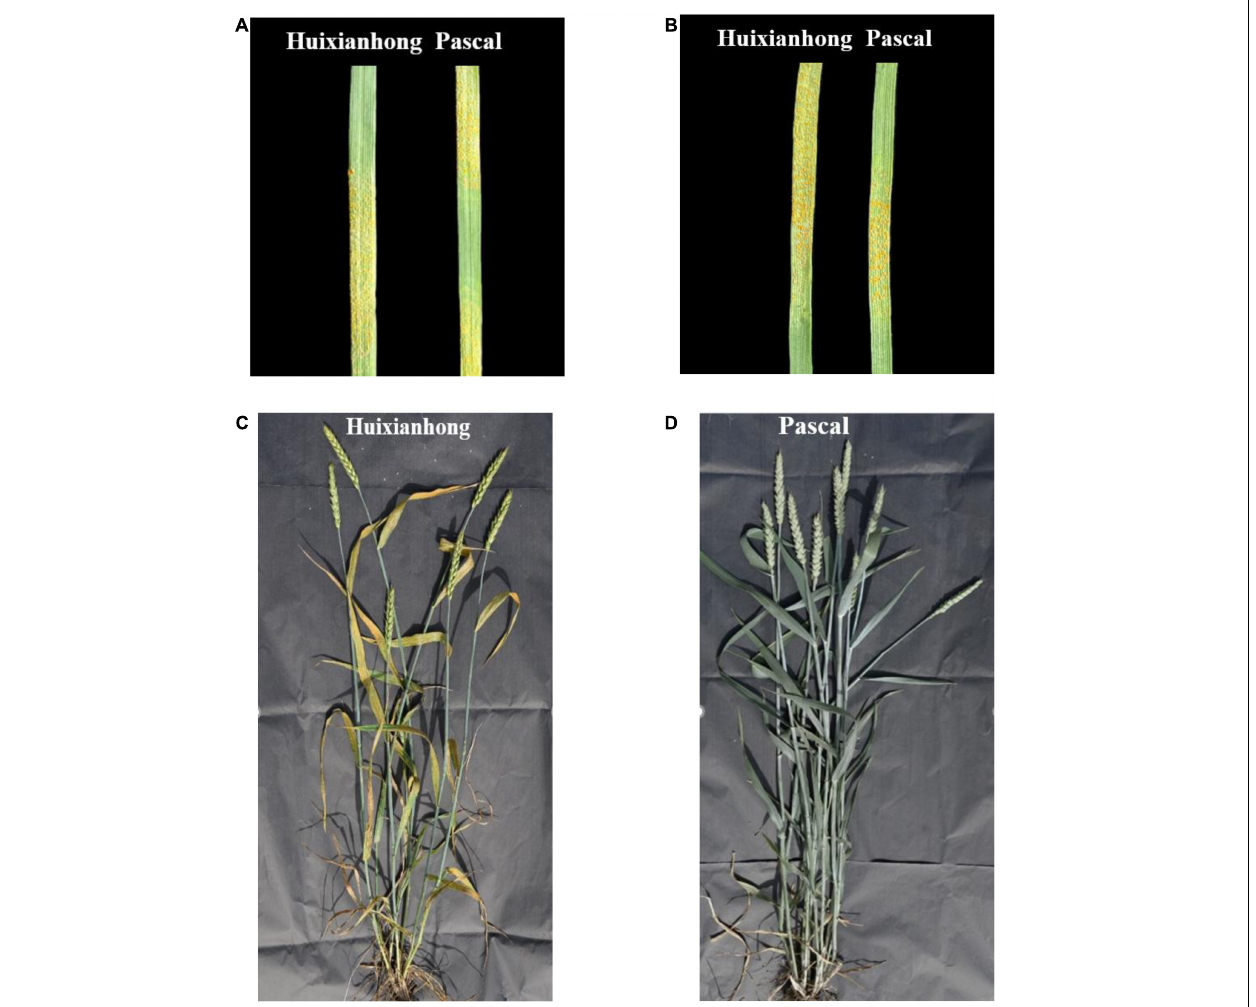
FIGURE 1 | The two parents Huixianhong (left) and Pascal (right) showed susceptible against stripe rust race CYR32 (A) and CYR33 (B) at the seedling stage. The response of susceptible parent Huixianhong (C) and the resistant parent Pascal (D) in the adult plant stage under Gansu province field